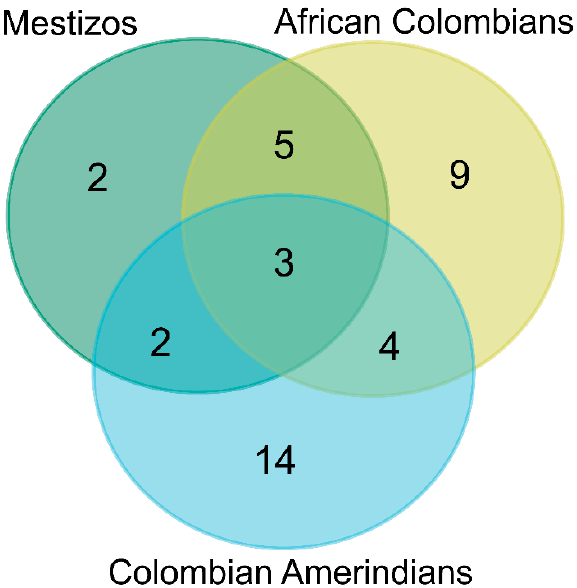
Figure 2. Venn diagram of the HLA II alleles with weighted allele frequencies (WAFs) over 5% among ethnicities reported in the Colombian